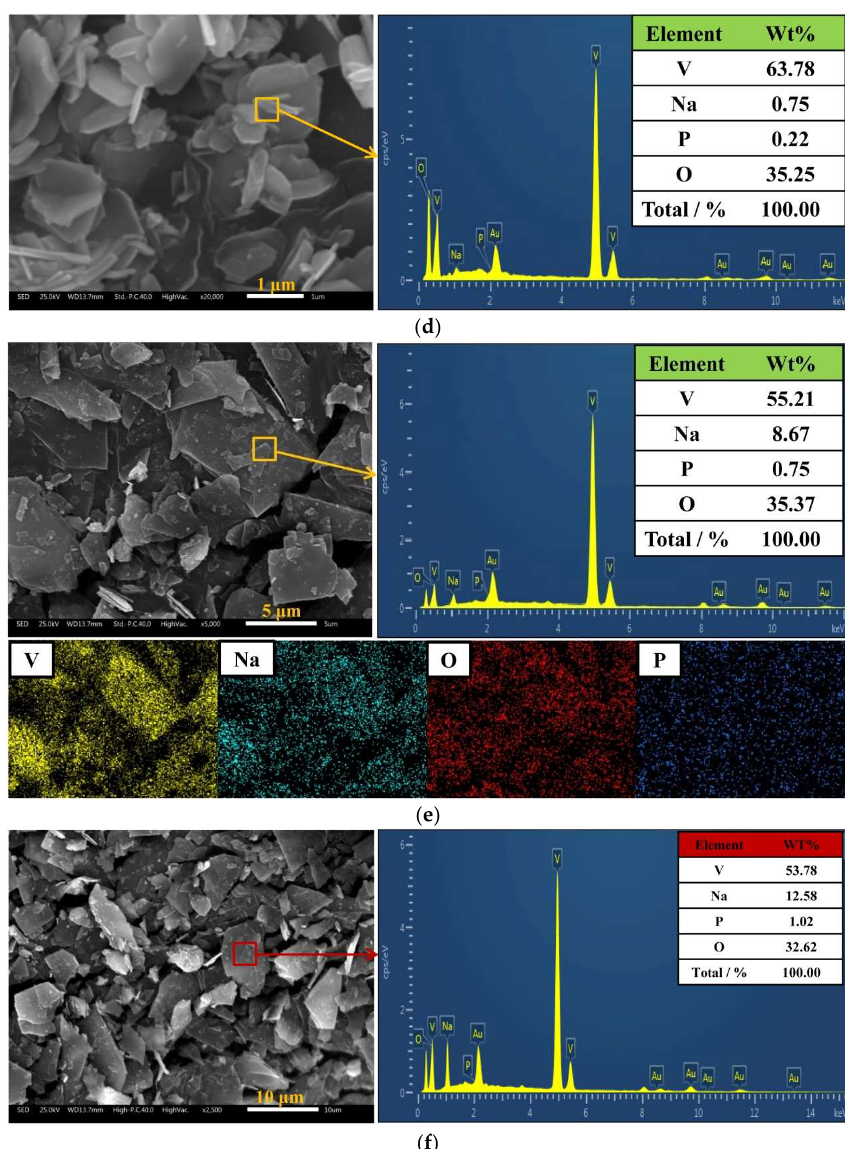
Figure 8. Scanning electron microscopy (SEM) images with EDS analysis of the precipitates obtained at different P concentrations of ( a ) 0.05 g/L; ( b ) 0.29 g/L; ( c ) 0.5 g/L; ( d ) 1 g/L; ( e ) 1.48 g/L and ( f ) 3 g/L in the feed solutions.